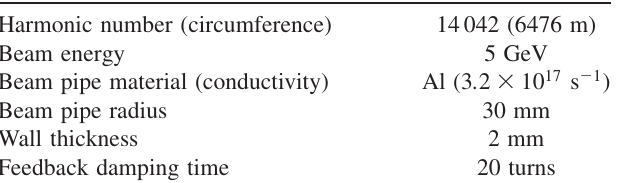
TRANSIENT JITTER FROM INJECTION IN . . TABLE I. ILC damping rings parameters used in simulation studies.